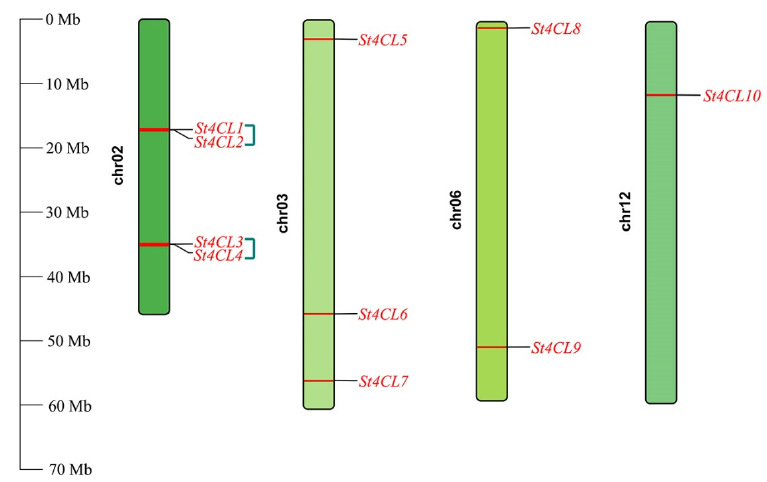
Figure 4. Distribution of the St4CL gene family on potato chromosomes. The two genes connected by green lines were tandem duplication genes.